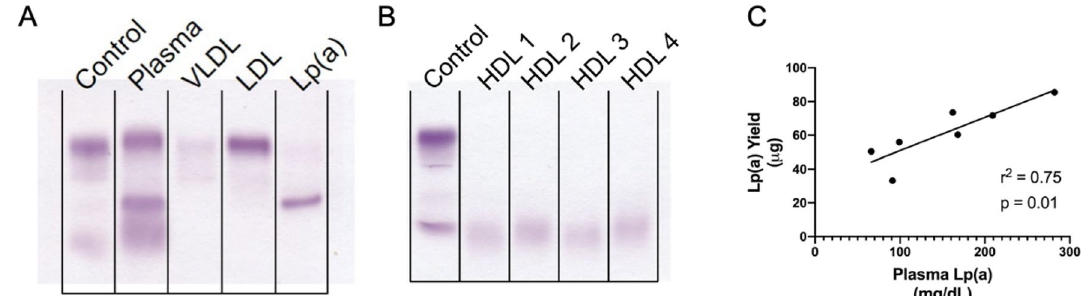
Figure 2. Lipid gel analysis demonstrates lipoprotein fraction purity following small-volume isolation. 0.4 mL of patient plasma was subjected to a two-step density gradient ultracentrifugation using